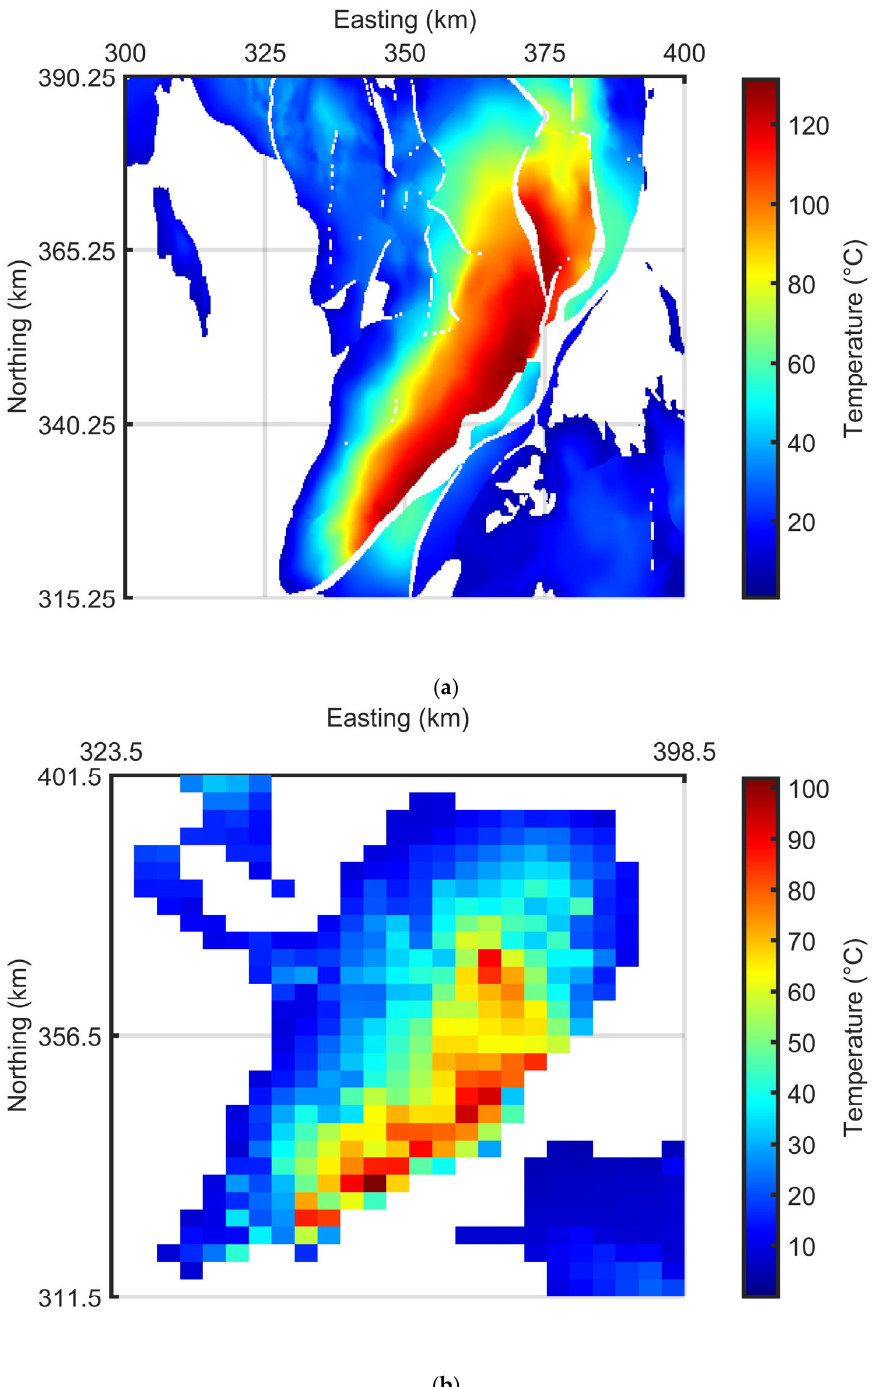
Figure 5. ( a ) Temperature map of the Cheshire Basin using 27 °C/km geothermal gradient. Resolution of 250 m spacing. Derived from South West Pennines Model, Lithoframe 3D model—250K data, 13,160 km 2 scale BGS Digital Data under License 2022/067-V2 British Geological Survey © and Database Right UKRI. All rights reserved [58]. ( b ) Temperature map of the base of Triassic sandstones. Resolution of 3 km spacing. Temperature maps derived from BGS depth maps. Contains British Geological Survey materials Copyright NERC 2022 [59].